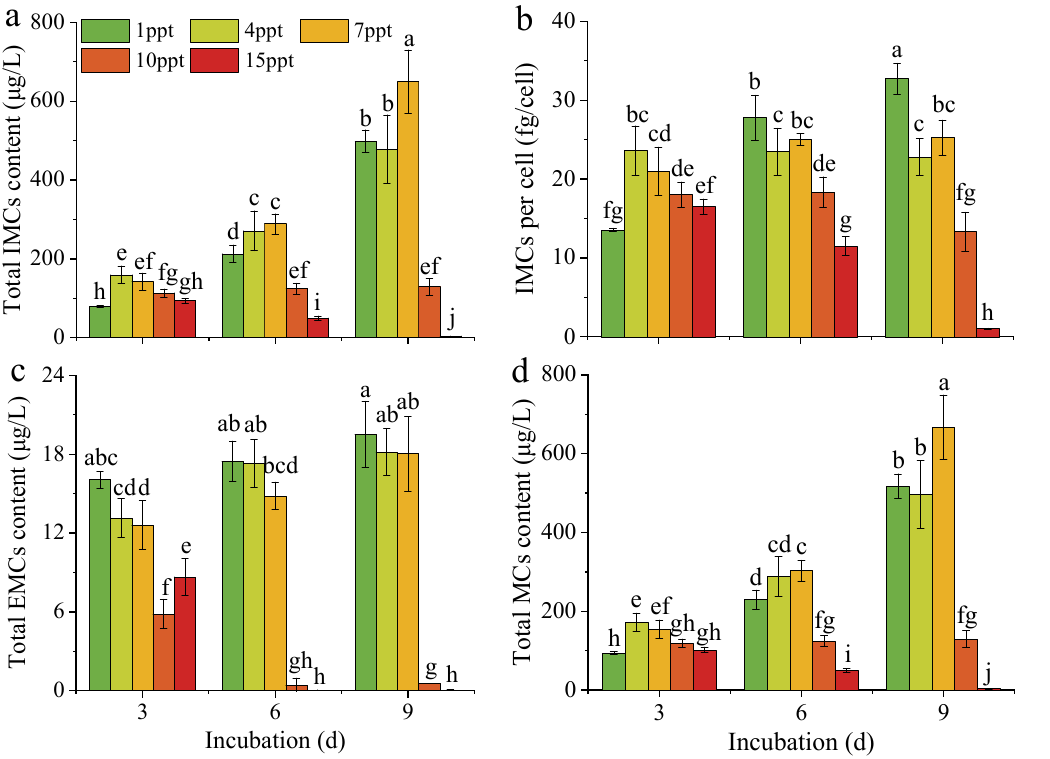
Figure 4. Contents of total intracellular MCs ( a ), intracellular MCs per cell ( b ), total extracellular MCs ( c ) and total MCs ( d ) under different salinity stresses on days 3, 6 and 9. Different letters a–j in the histogram indicate significant differences (ANOVA, p < 0.05).